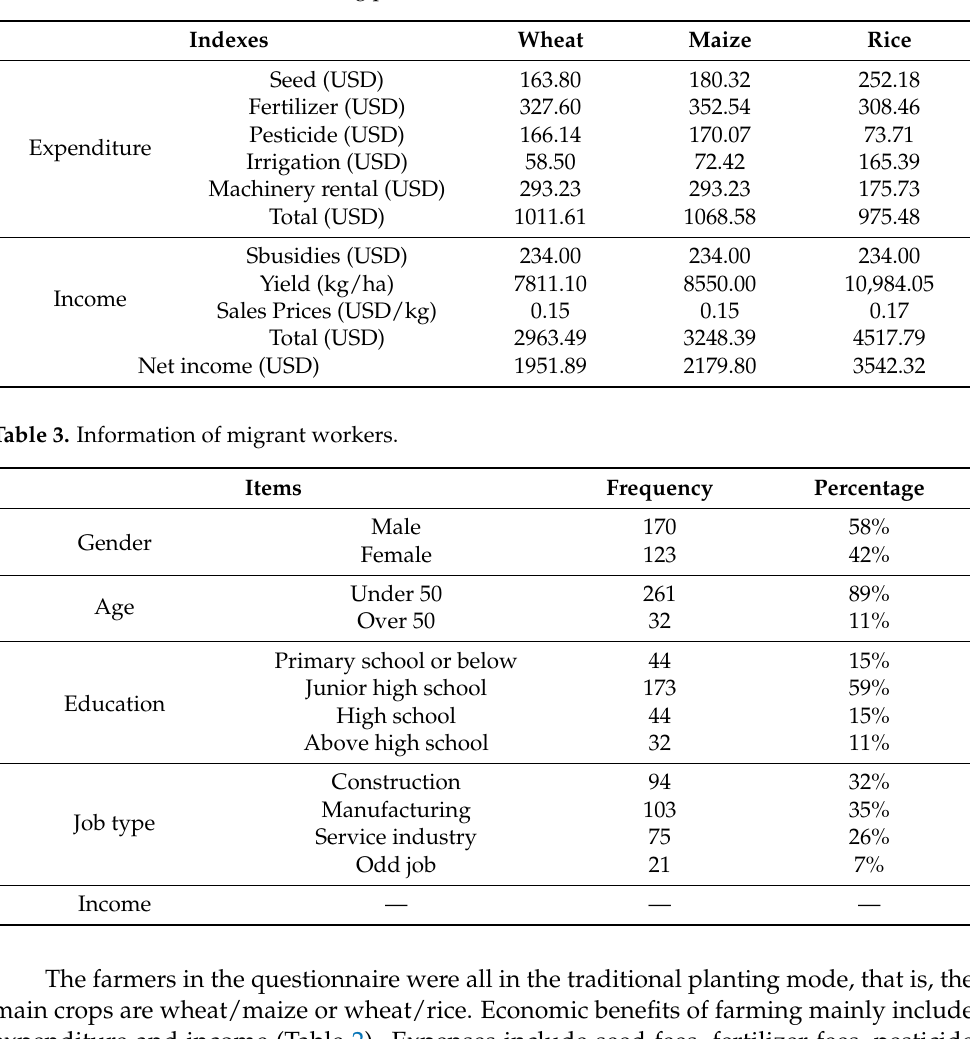
Table 2. Economic benefits of farming per hectare of arable land.